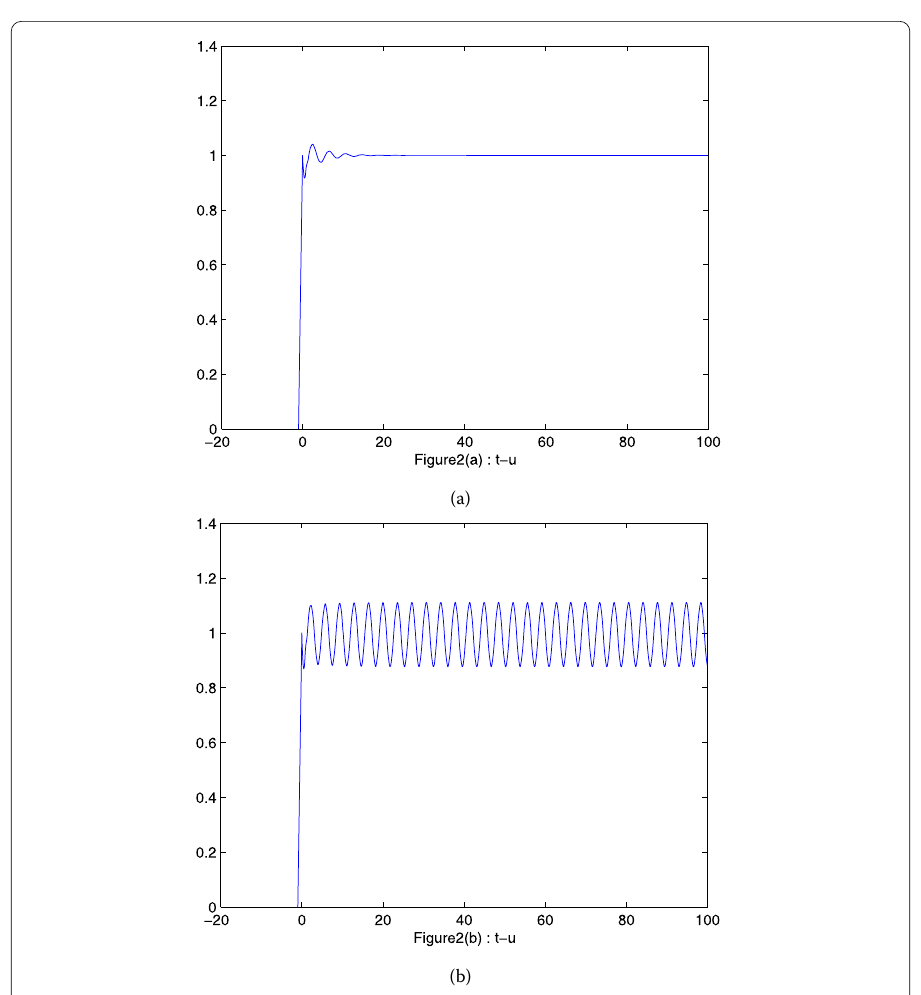
Figure 2 The numerical solution of Eq. (2.11) with PD control Euler method corresponding to k p = 0, k d = 0 when ( a ) τ = 3, ( b ) τ = 5